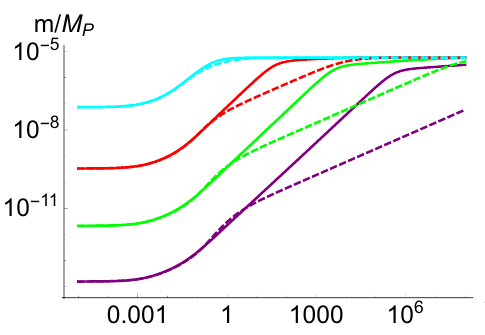
Figure 14. m vs. ξ for δ = 10 − 6 , 10 − 4 , 10 − 2 , 1 respectively in purple, green, red and cyan with N e = 60 e -folds in region 3. Continuous/dashed line represents metric/Palatini